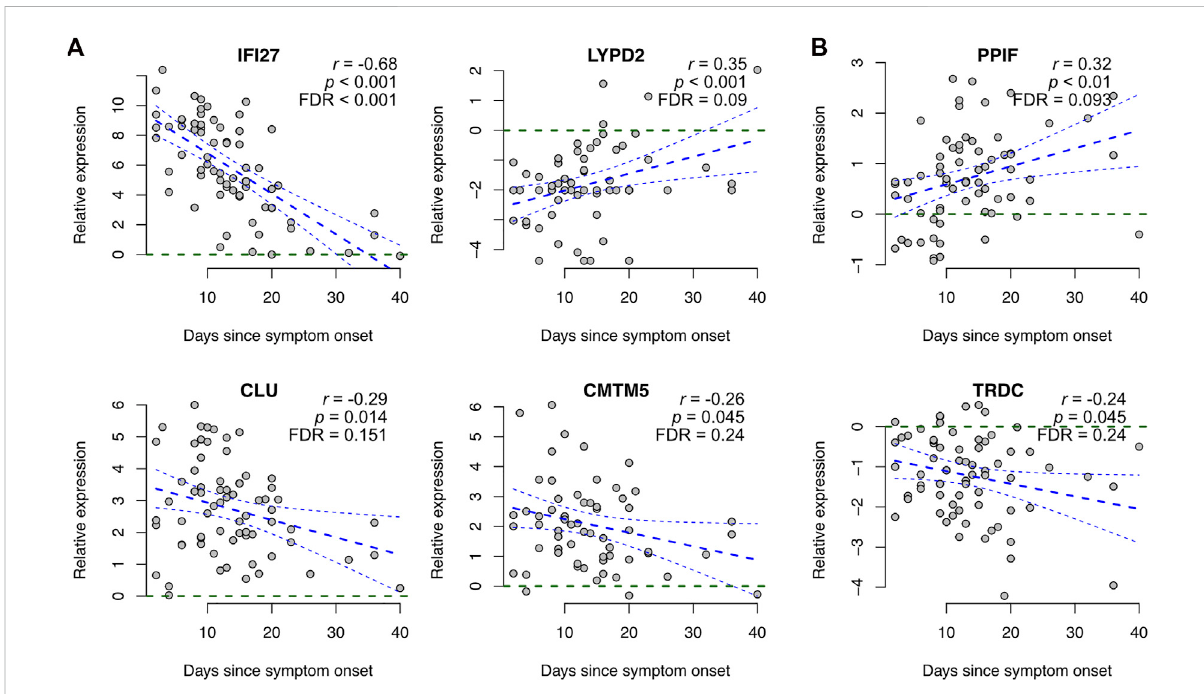
FIGURE 3 Association of COVID-19 speci fi c signature genes with time from symptom onset. Representative examples of genes showing a signi fi cant association between expression and time from symptom onset, including (A) genes becoming closer to the healthy controls at later stages and (B) genes showing larger differences at the later stages. Gene expression levels of COVID-19 patients were scaled to healthy controls within each dataset and plotted as a function of days since symptom onset across all datasets that had the symptom onset information available (Arunachalam, Combes, Liu, and Wilk), including linear regression with 95% con fi dence interval. Additionally, the Pearson correlation coef fi cients (r) and the corresponding p -values are shown. Visualizations of all signature genes are available in our online tool (https://elolab.shinyapps.io/